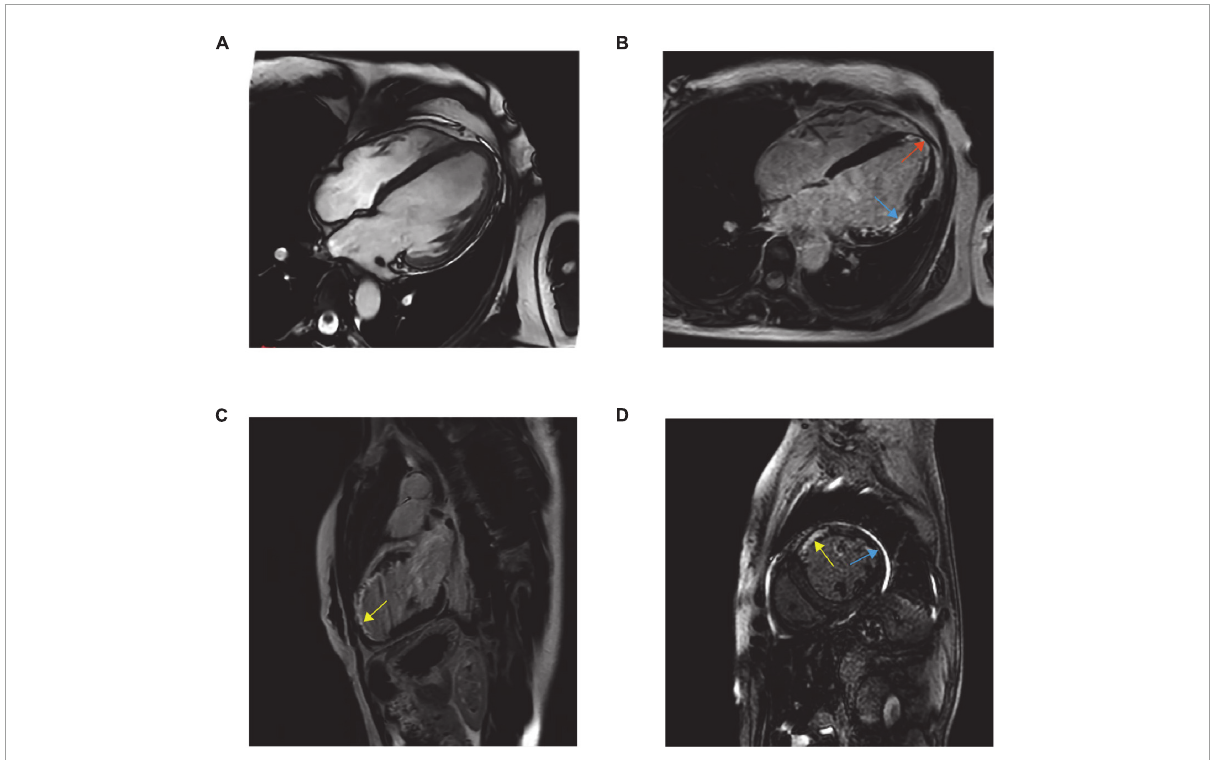
FIGURE1 Balanced steady-state free precession MR images are obtained in standard cardiac planes. Long-axis and four-chamber view (A) , long-axis and four-chamber late gadolinium-enhanced MR image (B) , long-axis and two-chamber view (C) , and short-axis and two-chamber view (D)